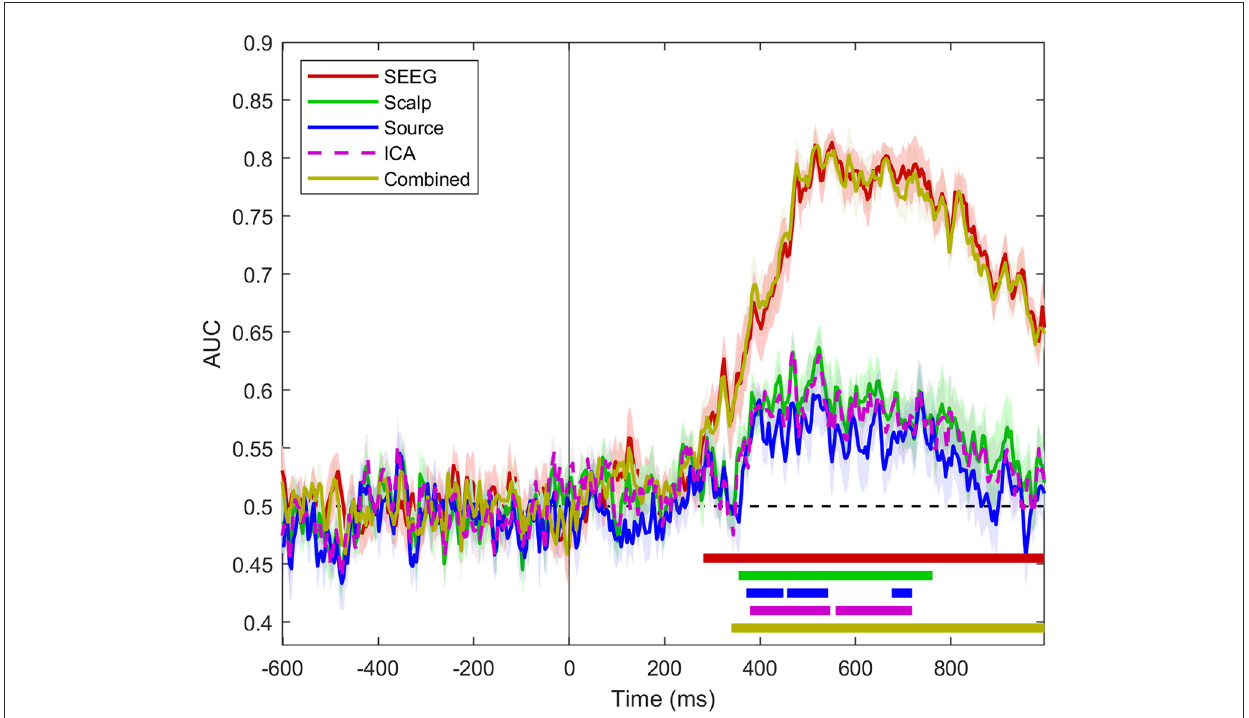
FIGURE4 Classifier performance for SEEG, scalp, source, ICA, and combined scalp SEEG signals for all n = 12 subjects. The dashed areas show standard error intervals for the set of classifier scores for all patients. The horizontal bars indicate the intervals where the scores are statistically different from chance (one-sample permutation cluster test, p <